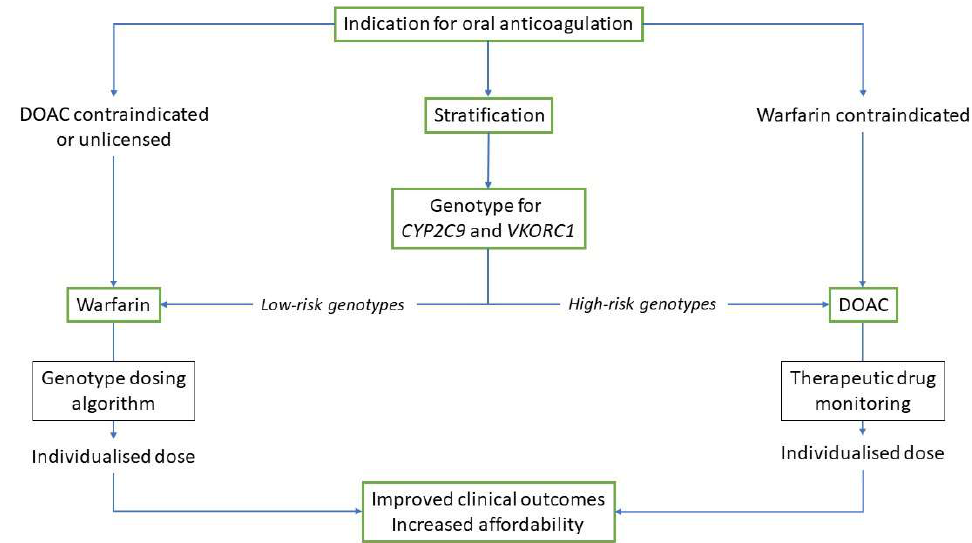
Figure 1. Clinical pathways for stratification in the use of oral anticoagulants. Use of either warfarin or a direct oral anticoagulant (DOAC) would require individualisation of the dose to improve time in therapeutic range and optimisation of anticoagulation, resulting in improved clinical outcomes. This would also result in improved affordability.